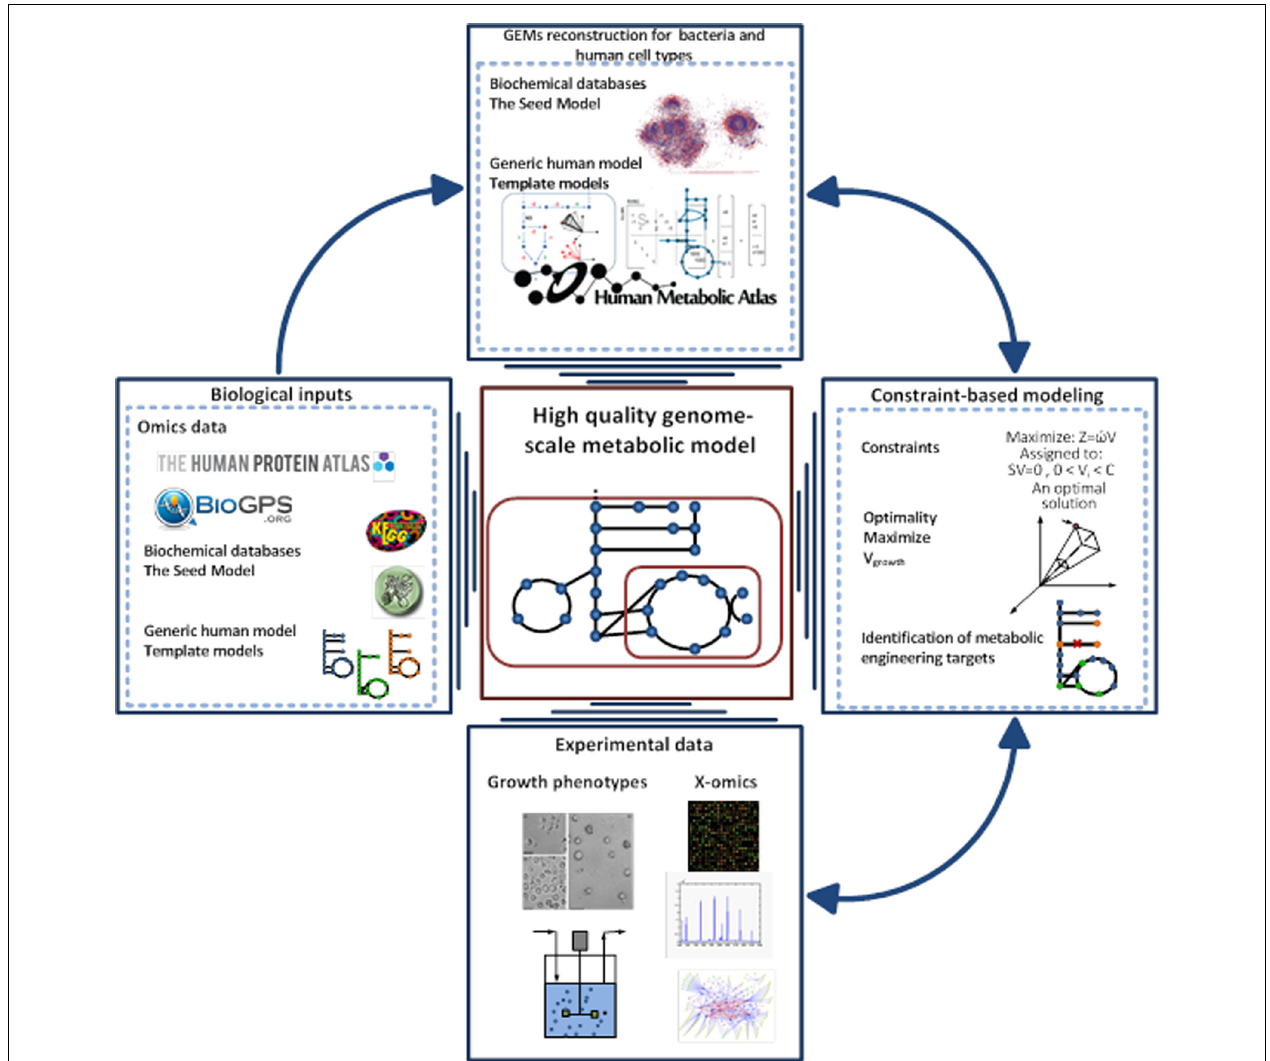
can generate the models in different formats, visualizing the simulations and overlaying the model in a metabolic map. Another powerful plug in is the INIT algorithm, which can be used for reconstruction of tissue-specific models based on a human generic metabolic model (Agren etal., 2012).The GEMs for tissues and microbes can be validated through constraint-based modeling approaches and available experimental